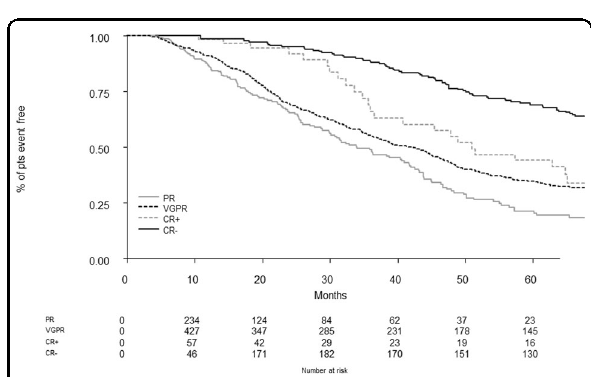
Fig. 3 PR, partial response; VGPR, very good partial response; CR, complete response; pts, patients. Progression-free survival in the intention-to-treat population (best overall) strati fi ed by